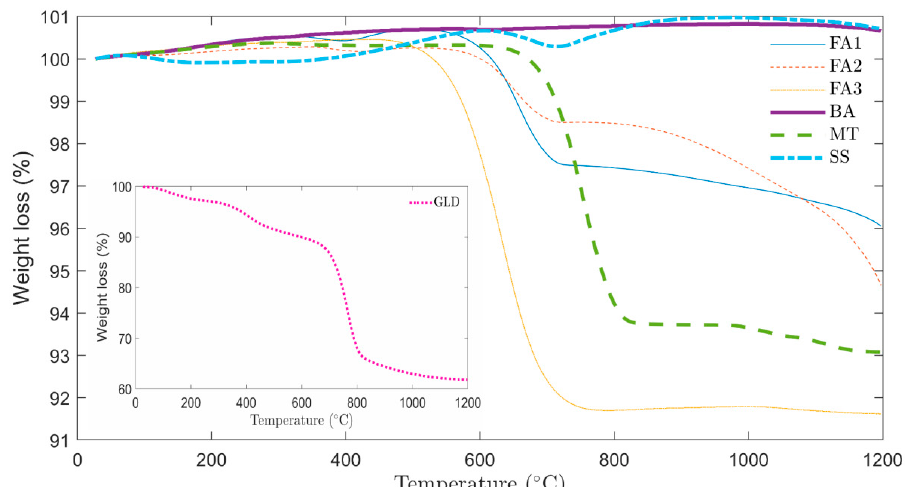
Figure 4. TG curves of the samples: FA1 (biomass fly ash 1), FA2 (biomass fly ash 2), FA3 (coal fly ash), BA (biomass bottom ash), GLD (green liquor dregs), MT (coarse limestone tailings) and SS (steel slag).